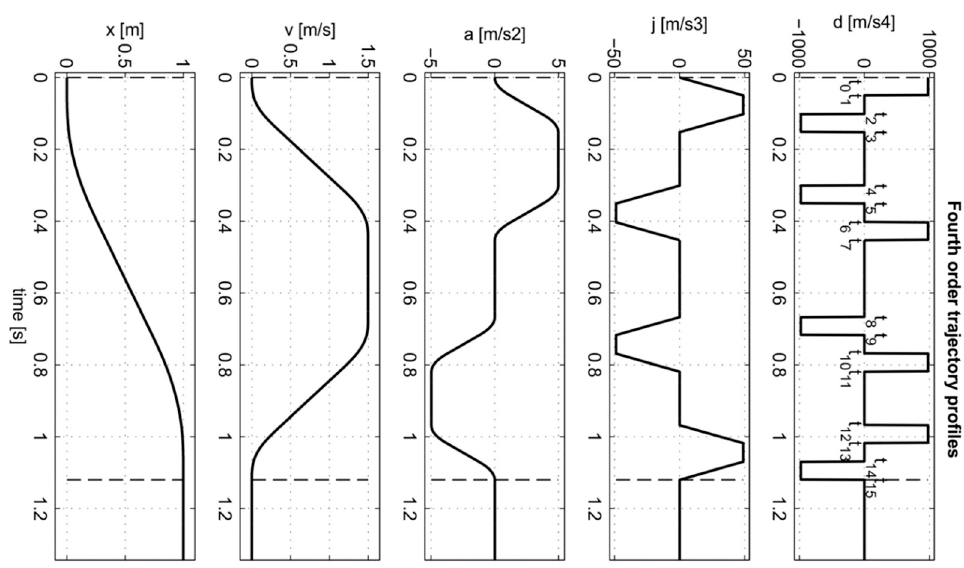
Figure 4. Fourth order trajectory profiles in point-to-point movement (MC_MoveAbsolute).